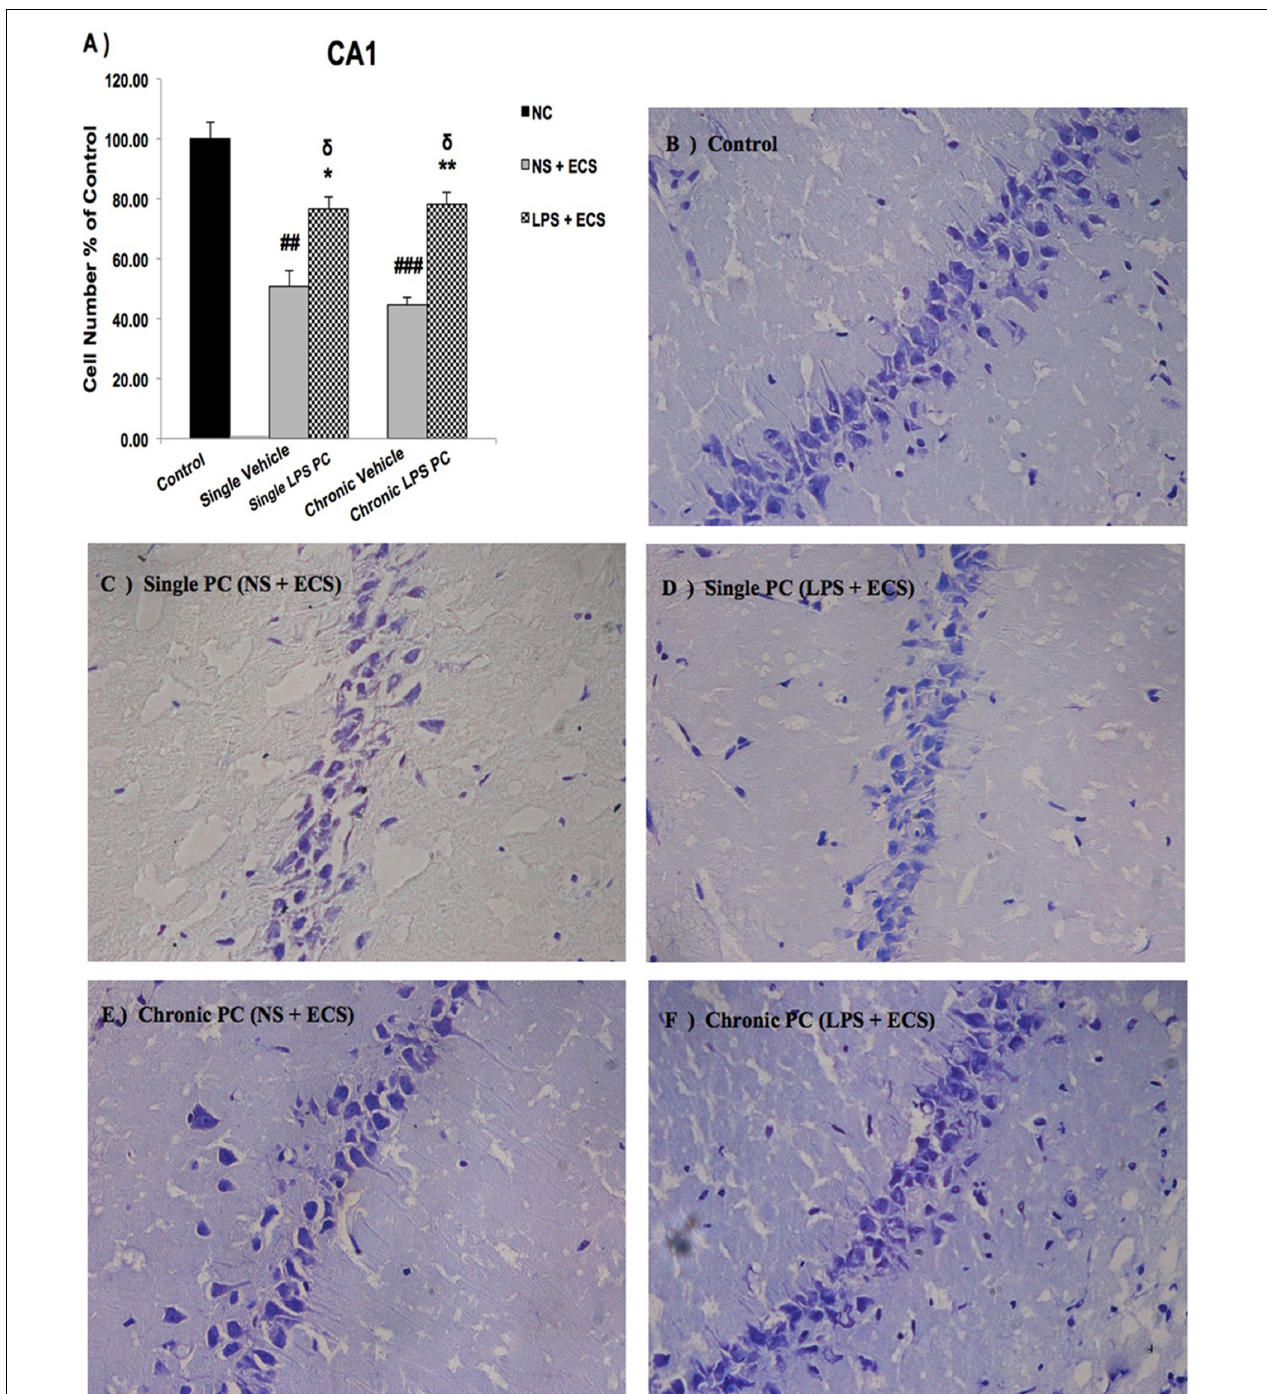
FIGURE 3 | Photomicrographs of Nissl-stained CA1 sub-region of rat brain hippocampus in the ECS model of epilepsy. (A) Effect of single low dose and chronic ultra-low dose of LPS preconditioning on the number of CA1 cells, (B) control, (C) vehicle (single NS), (D) single LPS preconditioned groups, (E) vehicle (chronic NS), and (F) chronic LPS preconditioned groups in the ECS model. Scale bars are equal to 50 µ m. Asterisk ( ∗ ) denotes a significant difference between the preconditioned groups and vehicle groups. Delta ( δ ) denotes a significant difference between the preconditioned groups and control groups. Hash (#) denotes a significant difference between the vehicle groups and control groups. Statistical analysis has been done according to the one-way ANOVA with significance levels of ∗ ρ < 0.05 and ∗∗ ρ < 0.01; δ ρ < 0.05; ## ρ < 0.01, and ### ρ < 0.001. Data are shown as mean% ± SEM of three animals ( n = 3), which expressed as the cell number percentage with respect to the control. ECS, electroconvulsive shock; NS, normal saline; LPS, lipopolysaccharide; PC, preconditioning; NC, no current was passed through the electrodes.